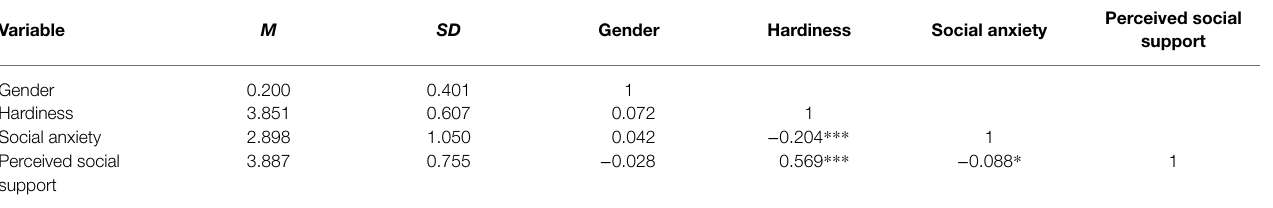
TABLE 5 | Descriptive statistics and correlations for all variables.